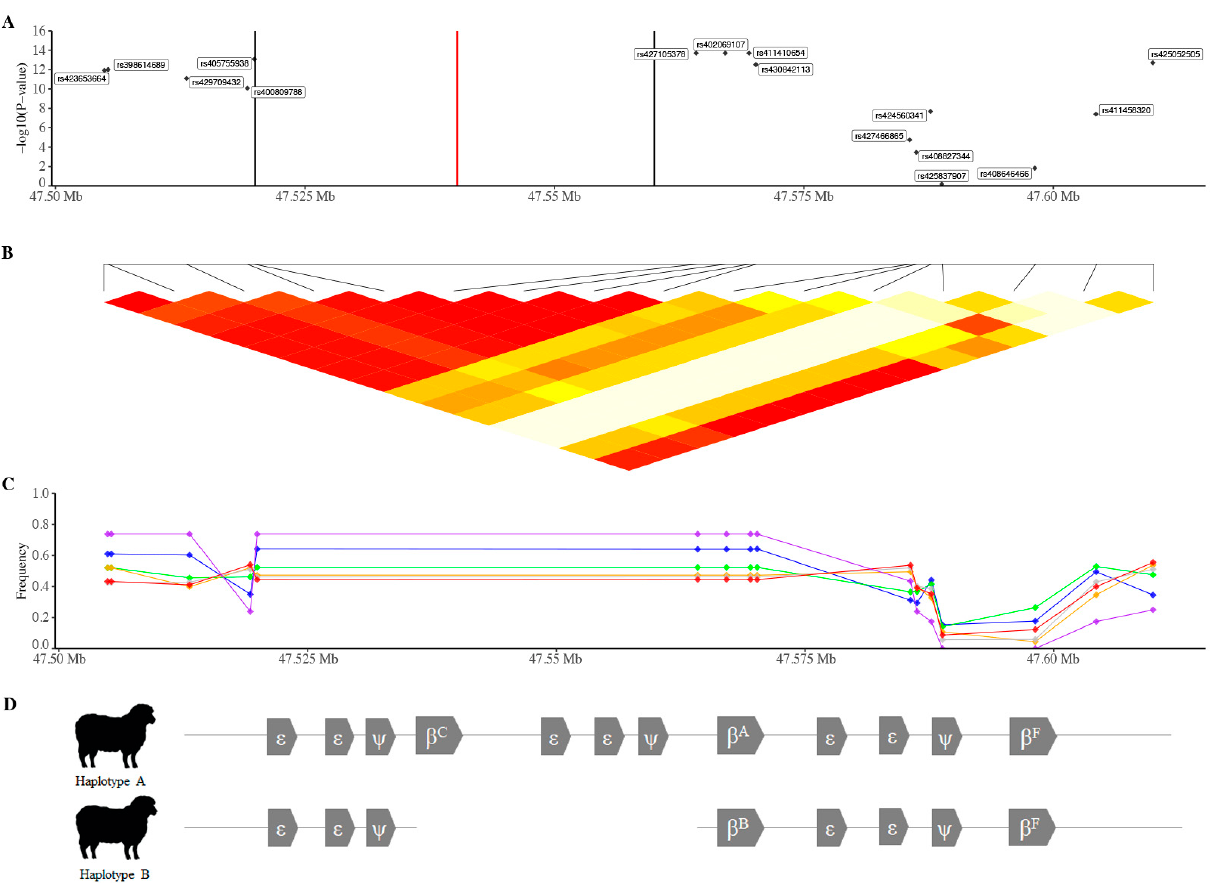
Figure 3. Detailed examination of the region underlying the GWAS peak on chromosome 15 (47,490 Kb–47,650 Kb). ( A ) Efficient Mixed-Model Association eXpedited (EMMAX) analysis using animals genotyped with either the Ovine Infinium ® HD SNP BeadChip or Illumina OvineLD BeadChip. ( B ) The previously reported [41] ~37-kb gap in the v3.1 sheep genome assembly is indicated by the red line. The ~40-kb region of low sequence identity between haplotype A and B (reference genome) is shown by the two black lines. Linkage disequilibrium (R 2 ), from 1 (red) to 0 (white). ( C ) Allele frequency (based on overall minor allele) by breed: Composite (blue); Coopworth (green); Highlander (orange); Perendale (grey); Romney (red); Wiltshire (purple), based on overall minor allele. ( D ) Schematic diagram of the β -globin locus (duplication of an ancestral four-gene set, ε - ε - ψ - β ), showing the arrangement of haplotype A and B. While both haplotypes A and B contain the adult β -globin gene, HBB , the two are considered allelic variants ( β A and β B ).